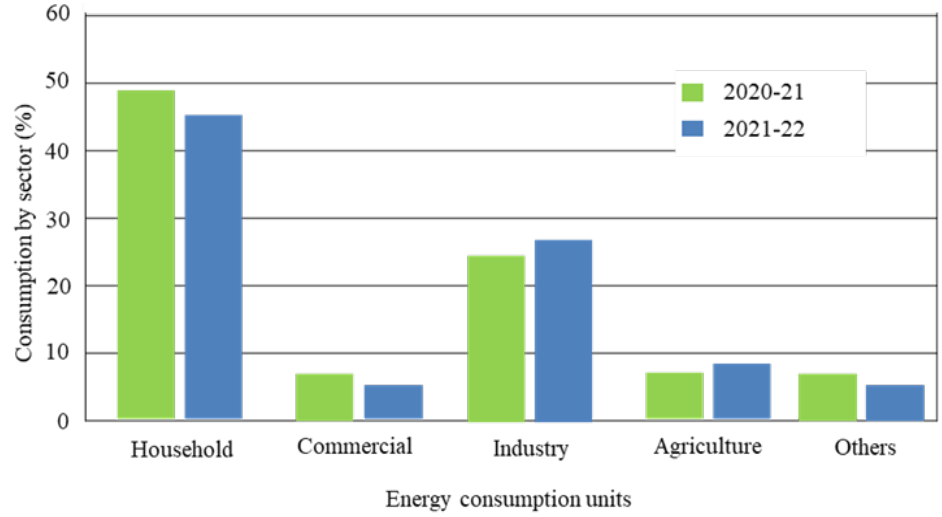
Figure 3. Sector Wise Share of Electricity Consumption in Pakistan, Source: Pakistan Economy survey 2021–22 [58].